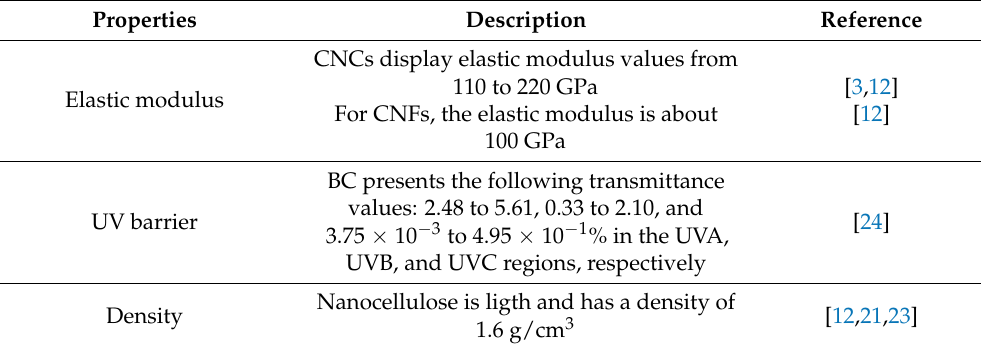
Table 6. Cont. Properties